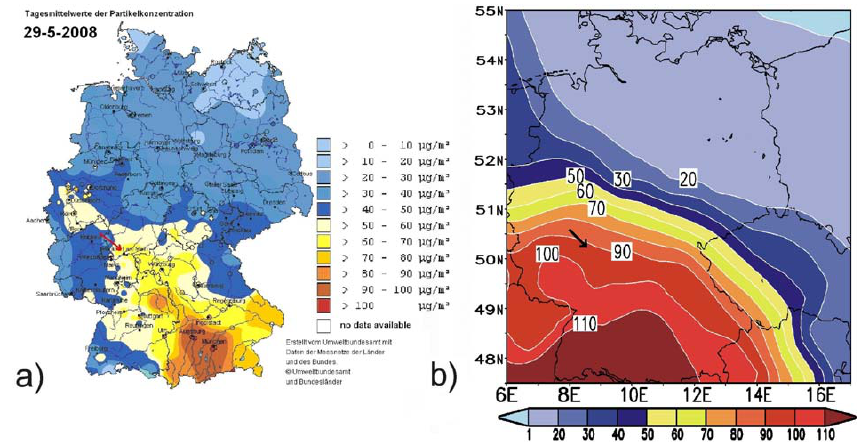
Fig. 5. Diurnal mean surface concentration by mass (µg/m 3 ) of aerosol particles with diameter < 10µm (a) measured in Federal and statewide networks on 29 May 2008 in Germany, (© data compiled by the German Federal Environment Agency, Umweltbundesamt); (b) simulated by DREAM model (size bins 1–7 in Table 1). (red and black arrows shows measurement-location Kleiner Feldberg).